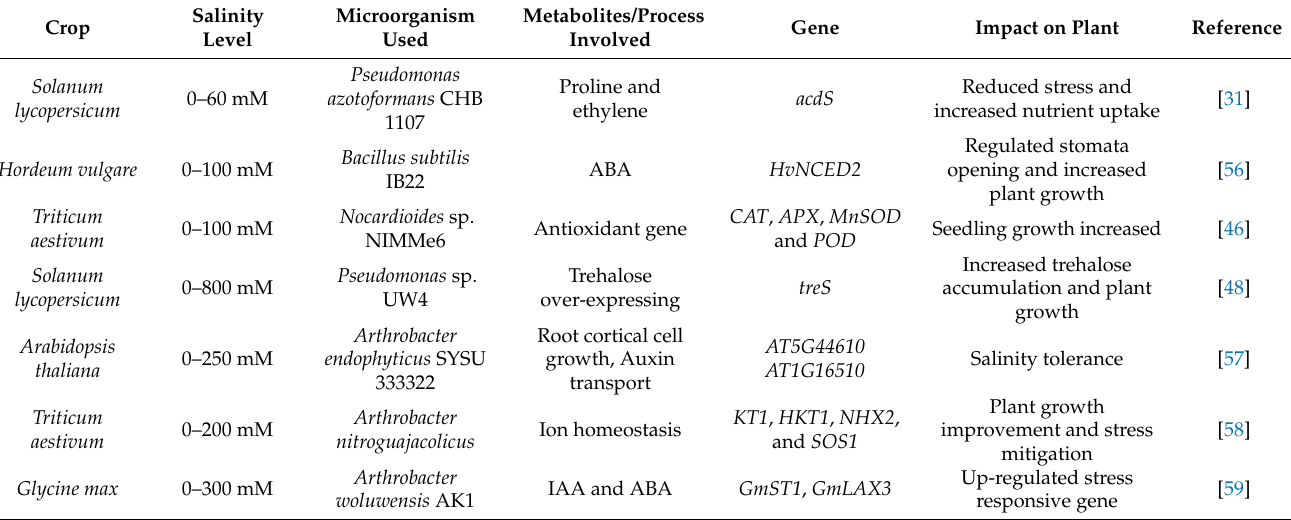
Table 1. Various metabolites produced by plant growth promoting bacteria in increasing the salt stress mitigation and growth of various